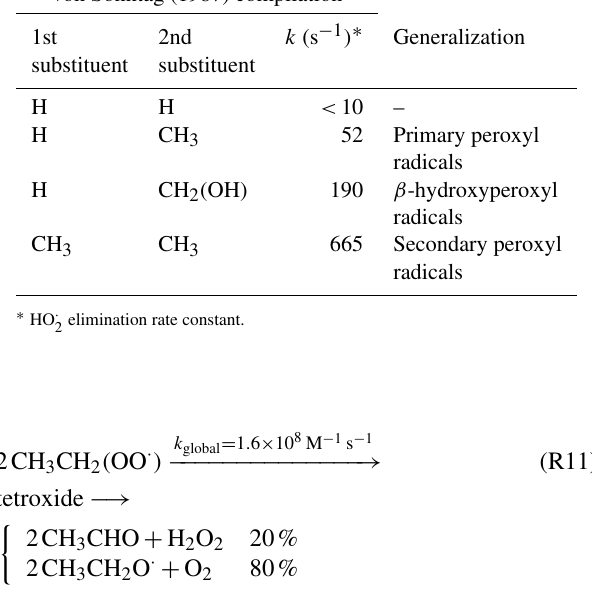
Table 3. Generalization of HO · unknown species, following von Sonntag (1987).